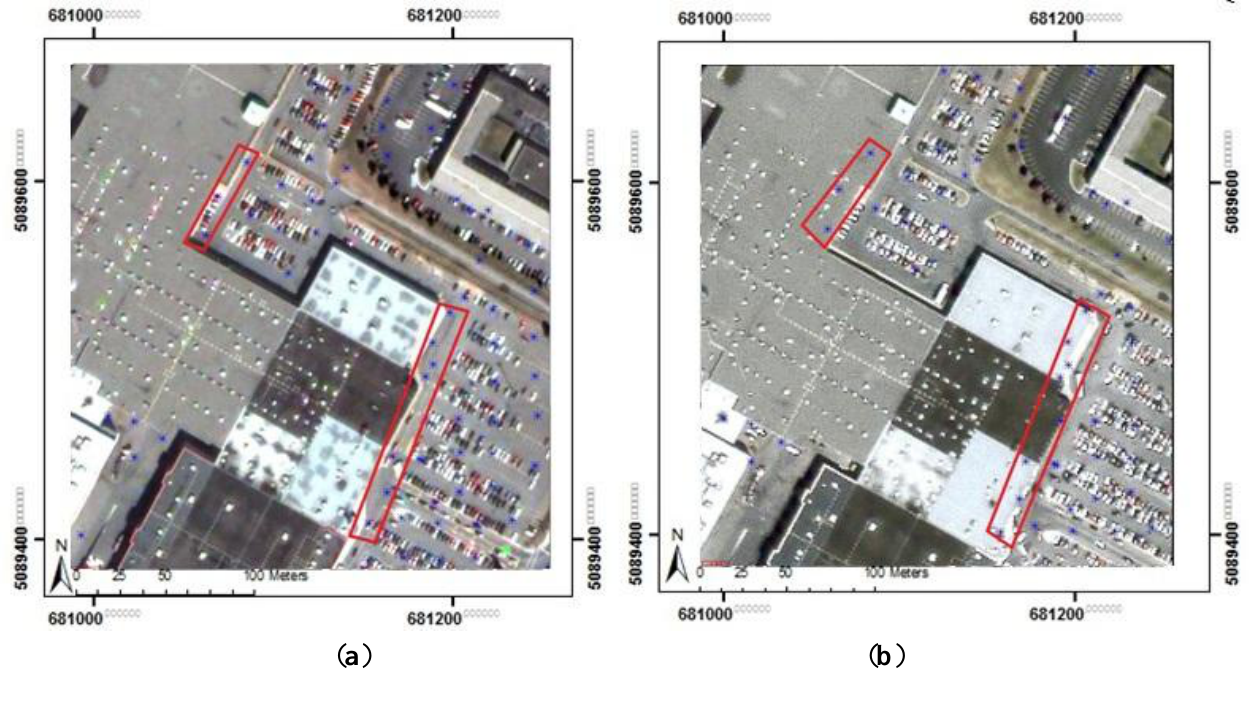
Figure 2. Misregistration between the Spot Height (SH) layer and the QB ( a ) and IKONOS (IK) ( b ) image. Asterisks represent the Spot Heights. Spot Heights were collected over non built-up areas; however, due to misregistration, some points lie on building roofs as shown in this Figure. As seen, misregistration is larger in IK than in